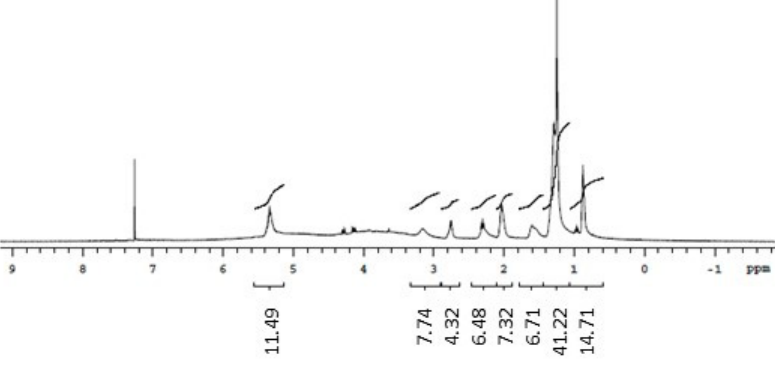
Figure 7. 1 H NMR spectrum (CDCl 3 , 300 MHz) of the biosurfactant from Glycine max.